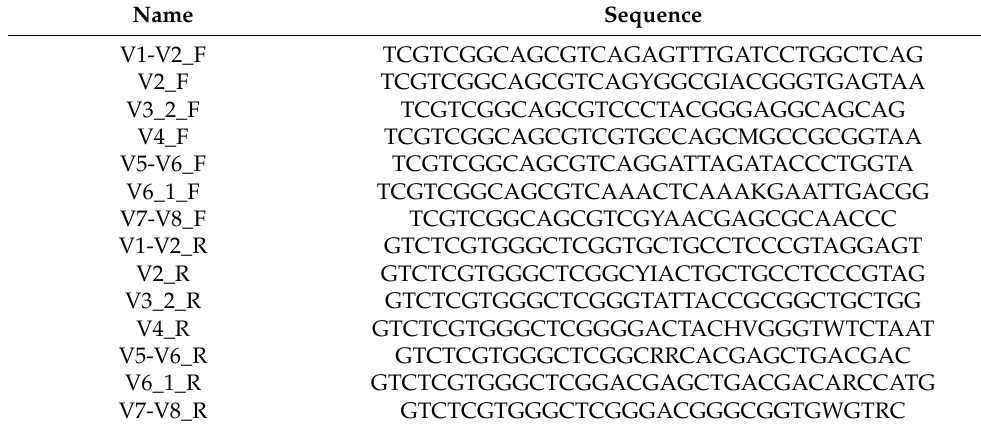
Table 2. Primers sequences associated with the seven PCR amplicons covering nine variable regions in the bacterial 16S rRNA